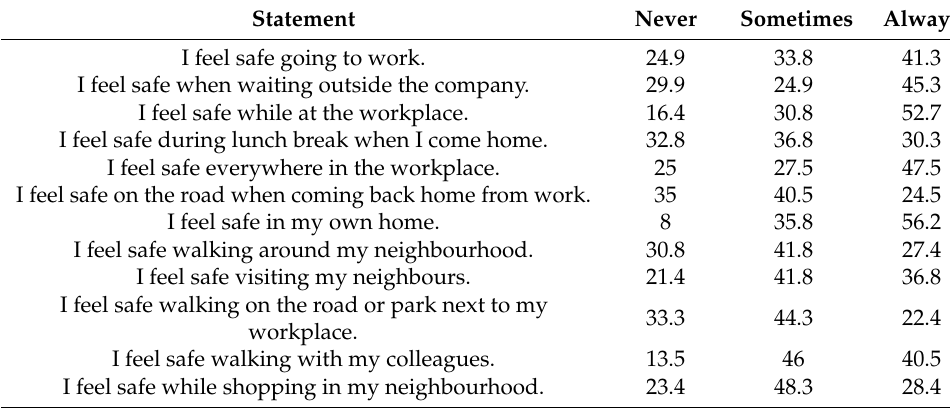
Table 2. Distribution of responses regarding personal safety [ n =